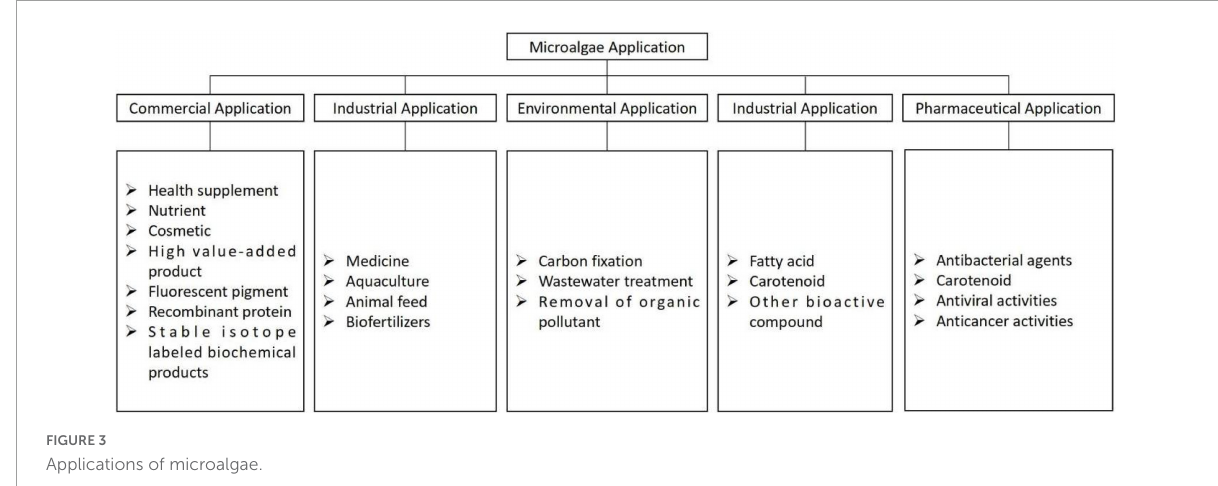
FIGURE3 Applications of microalgae.